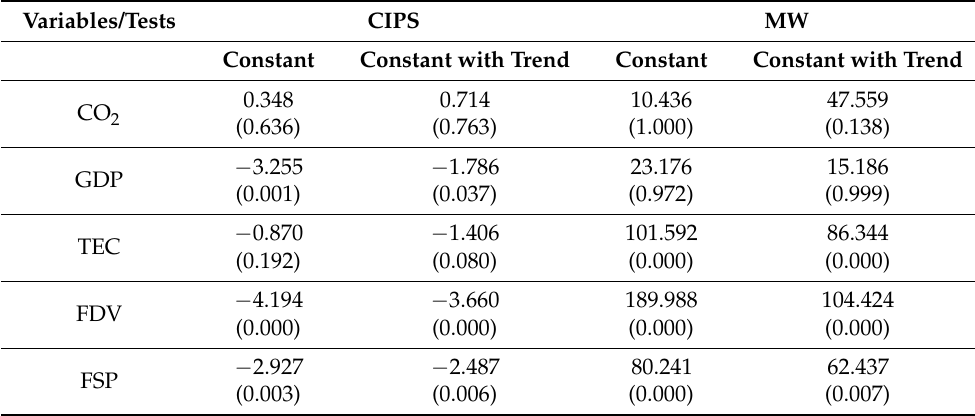
Table 4. The result of the unit root